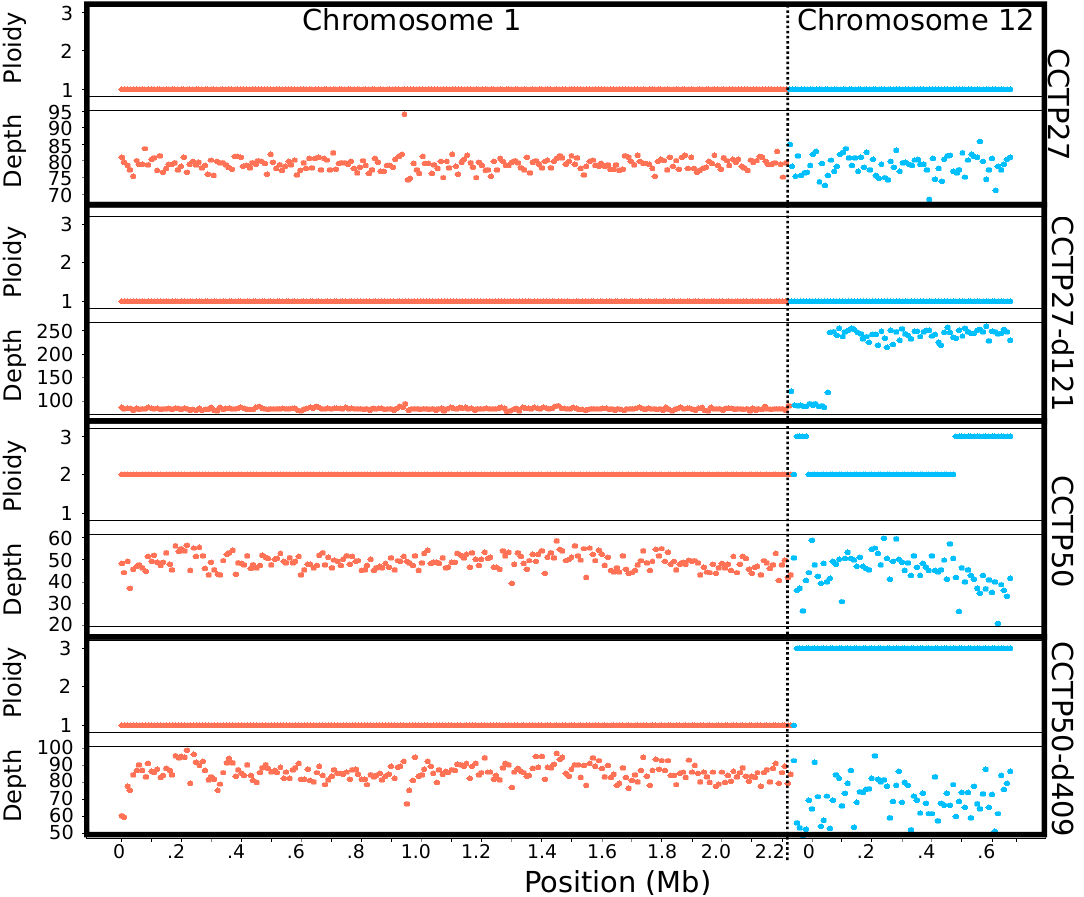
Figure 3. Inference of ploidy levels on two samples of Cryptococcus neoformans at different time points using HMMploidy . Inferred ploidy and corresponding sequencing depth are shown in genomic windows for two samples at day 1 (CCTP27 and CCTP50), day 121 (CCTP27-d121) and 409 (CCTP50-d409) on chromosomes 1 and